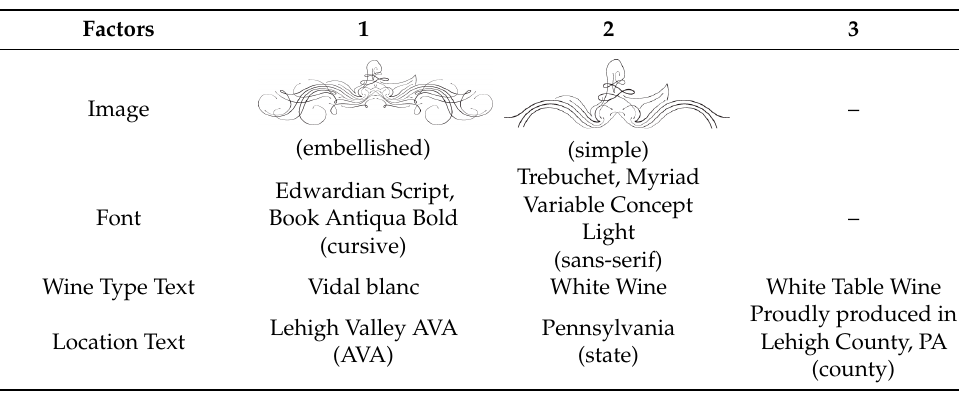
Table 1. Description of the four factors, and associated levels evaluated in the choice-based conjoint analysis (CBCA) experiment. Using an orthogonal design, each factor level was combined in all possible combinations and participants rated all 36 tasks.